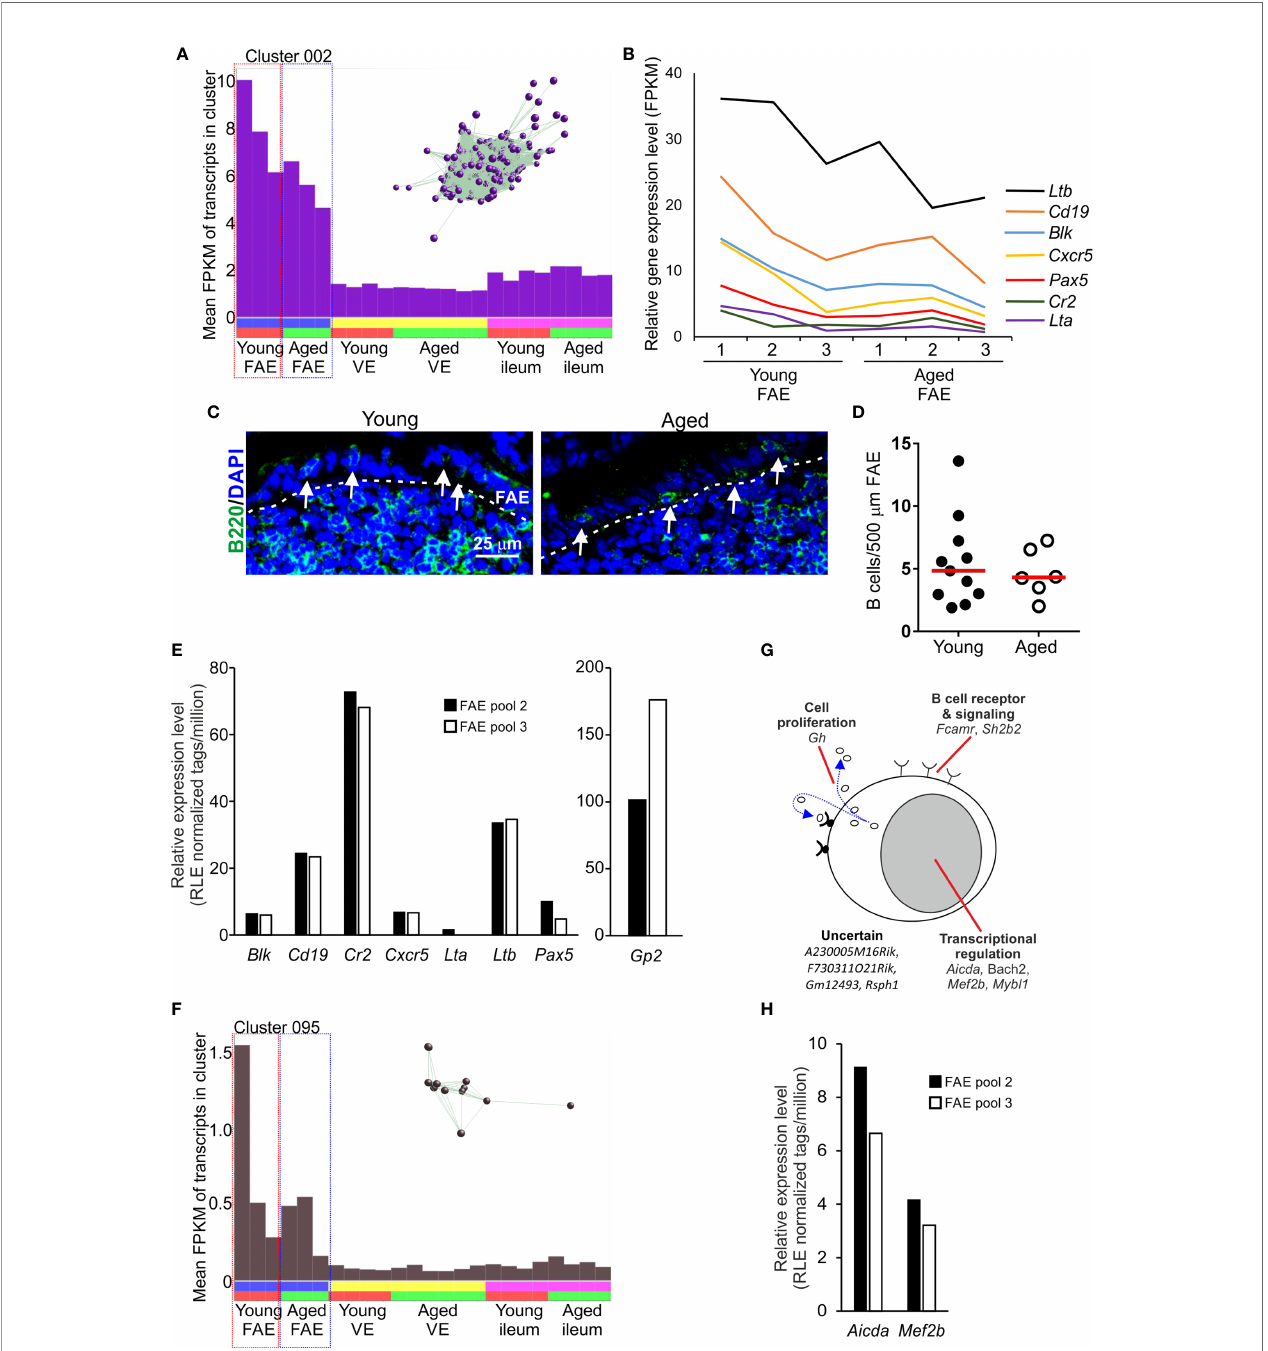
FIGURE 4 | Detection of B cell-related transcriptional signatures in FAE mRNA-seq data sets. (A) Mean expression pro fi le (mean FPKM) of the genes in Cluster 002 across the 24 data sets. Inset shows the grouping of nodes in this cluster in the network graph shown in Figure 2B . (B) Relative expression level (FPKM) of individual B cell-related genes in individual FAE mRNA-seq data sets from young and aged mice. (C) IHC detection of B220+ B cells (green, arrows) in the FAE. Cell nuclei counterstained with DAPI, blue. Dotted line indicates the boundary of the FAE. (D) Comparison of frequency of B cells (B200+ cells) in the FAE. N=6-12 FAE/ group. Horizontal bar, median. Statistical differences determined by t test. (E) Expression of mRNA encoding B cell-related genes in independent mRNA deep CAGE sequence data sets derived from FAE sheet preparations (44). (F) Mean expression pro fi le (mean FPKM) of the genes in Cluster 095 across the 24 data sets. Inset shows the grouping of nodes in this cluster in the network graph shown in Figure 2B . (G) Cartoon describing the putative function in B cells of the genes represented in Cluster 095. (H) Expression of Aicda and Mef2b mRNA in independent deep CAGE sequence data sets derived from FAE sheet preparations